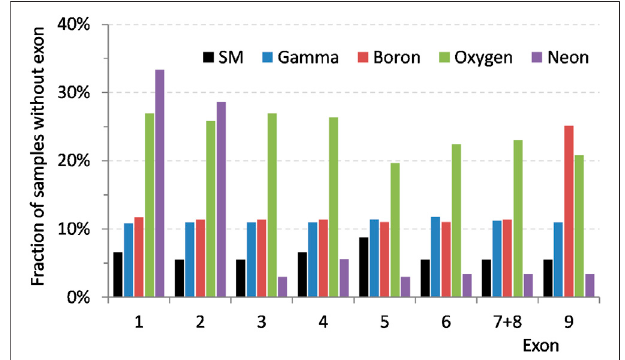
FIGURE 5 | Mutational spectra of HPRT spontaneous and ionizing radiation-induced mutants (doses and time points pooled together for each particular radiation) showing percentages of all the samples with particular missing exon.